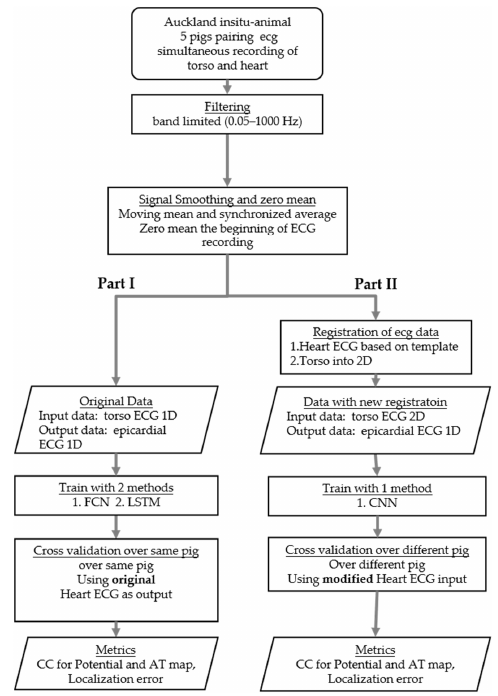
Figure 1. The overall study process. Part I indicates the study that trained the data for one pig only. Part II used data from all five pigs and had an additional step (registration of the electrogram data) that transformed the original data into a uniform data format. In terms of the metrics, the models were evaluated in two ways: (1) the correlation coefficients of the reconstructed electrogram and the recorded one, (2) the correlation coefficients for the AT map derived from the reconstructed and recorded electrograms. CC, correlation coefficients; AT, map activation time across all epicardial nodes.